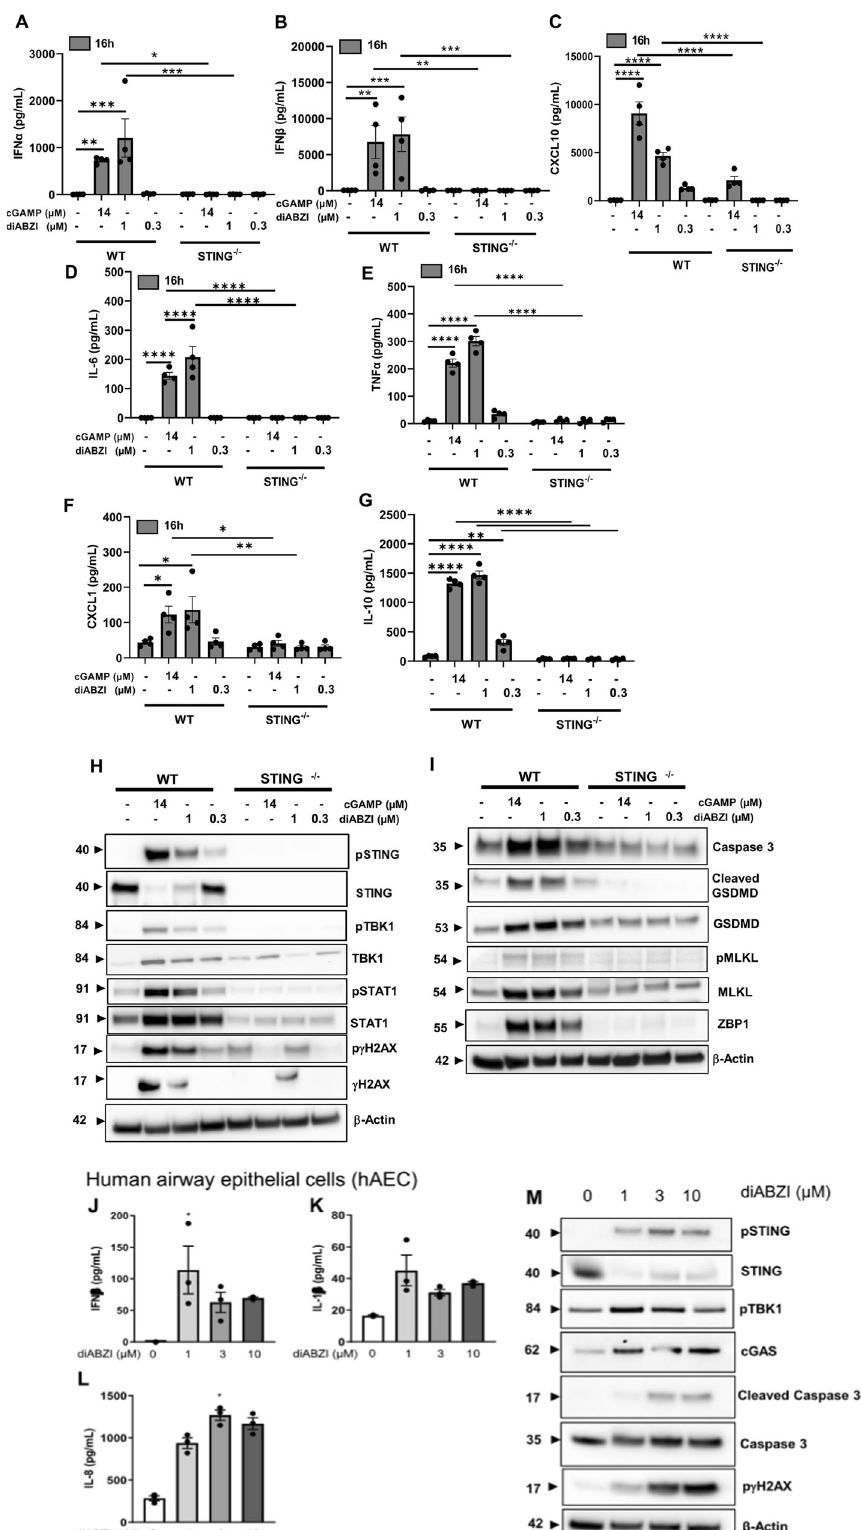
extracellularly, that acts as a strong danger signal recognized by nucleic acid sensors such as cGAS, we quanti fi ed nuclear and mitochondrial DNA released in the BALF in response to diABZI or cGAMP. While nuclear DNA was barely released, there was